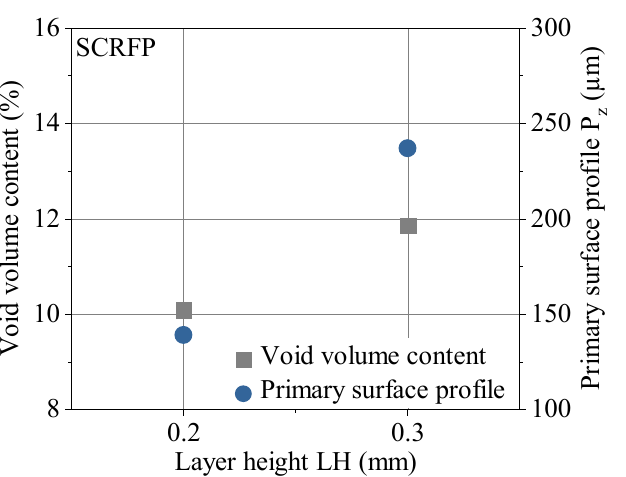
Figure 6. Results for the external and internal quality assessment via 3D laser scanning microscope and µCT.